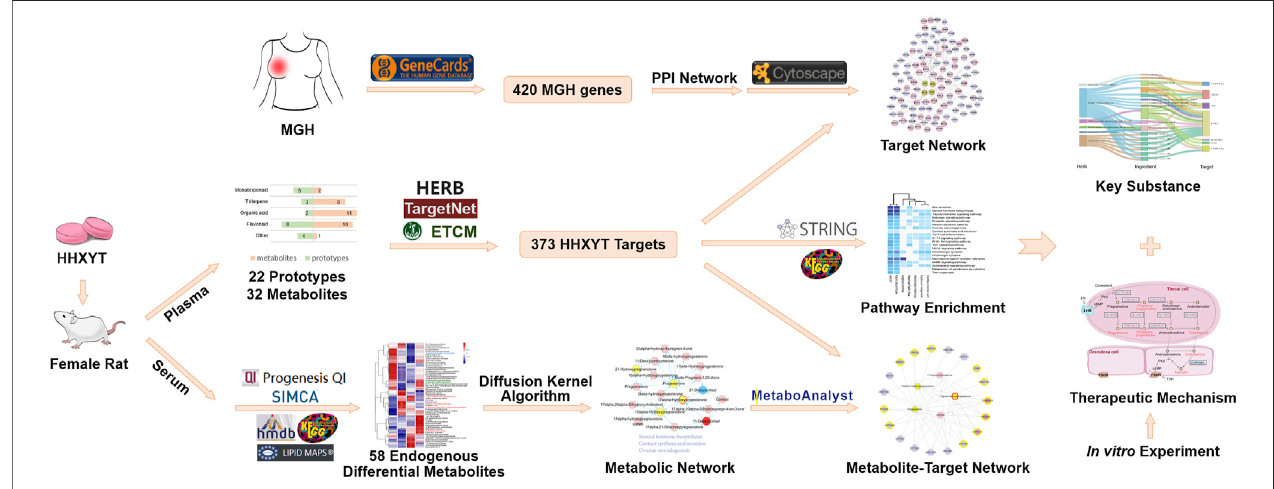
FIGURE 1 | Integrated work fl ow for exploring the potential mechanisms of HHXYT against MGH.